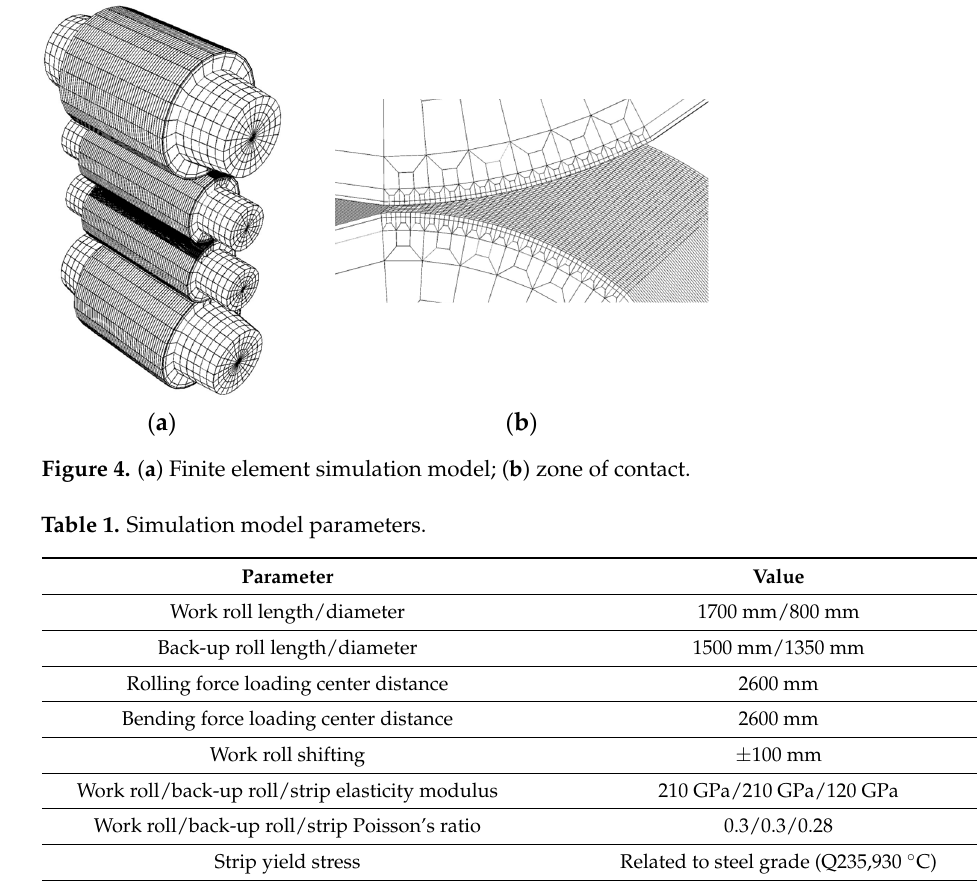
4 of 13 Table 1. Simulation model parameters. Parameter